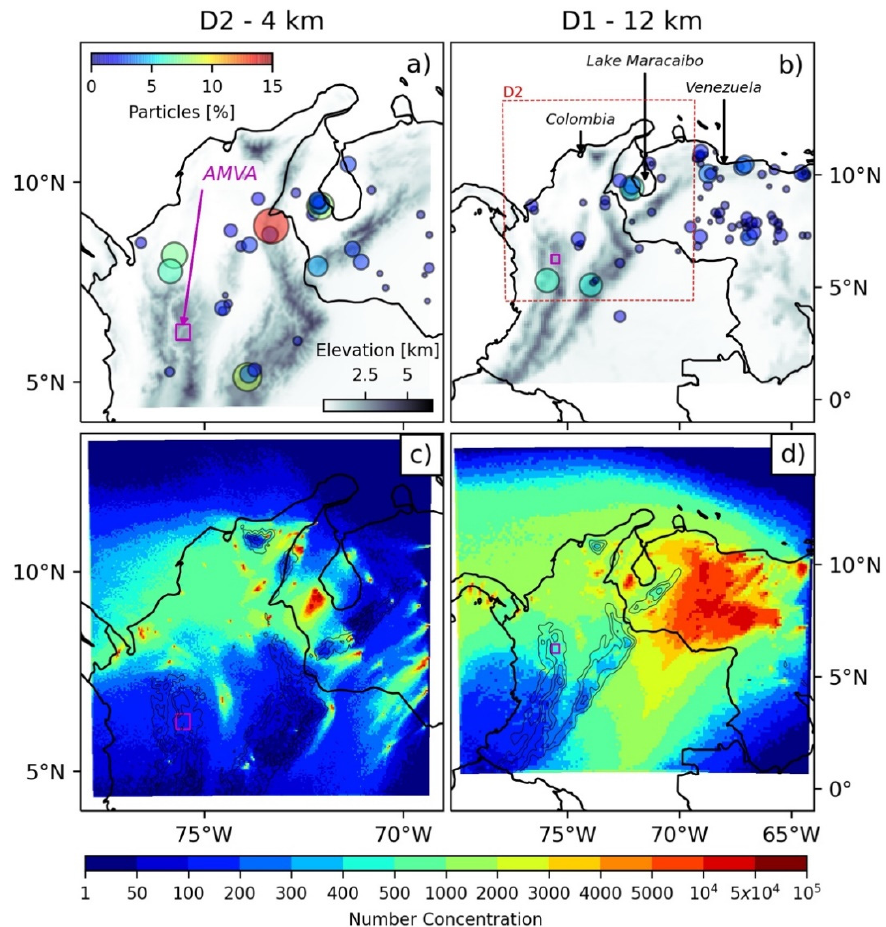
Figure 9. ( a ) Percent contribution of grid pixels to the total number of particles reaching AMVA for domain D2, full simulation; ( b ) as ( a ) but for domain D1, from 15–20 April. ( c ) Accumulated particle number concentrations (temporal and vertical column sums) for domain D2; ( d ) as ( c ) but for D1. Black contour lines show terrain elevations between 1.5 and 4.5 km, every 1 km. Note the nonlinear scale in panels ( c , d ).